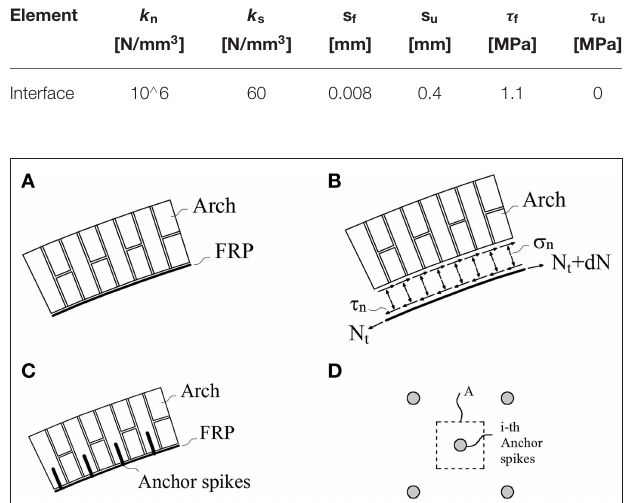
TABLE 5 | Prestwood bridge model: bond-slip constitutive law parameters. Element